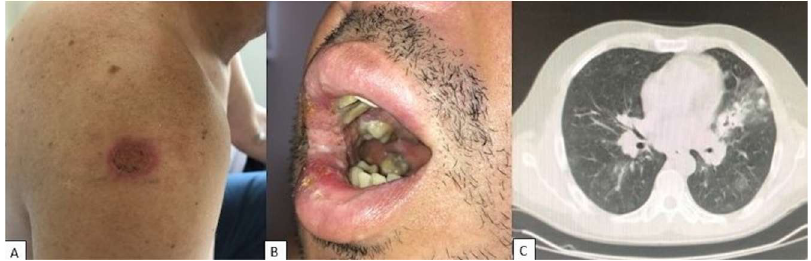
Figure 2. Clinical presentation of PCM-HIV coinfection. ( A ) Ulcerative lesions on the arm. ( B ) Moriform ulcerative perioral involvement. ( C ) Diffuse ground-glass opacities and consolidation in left superior lobe on chest computed tomography. Illustration provided by Dr. Adriana Maria Porro from